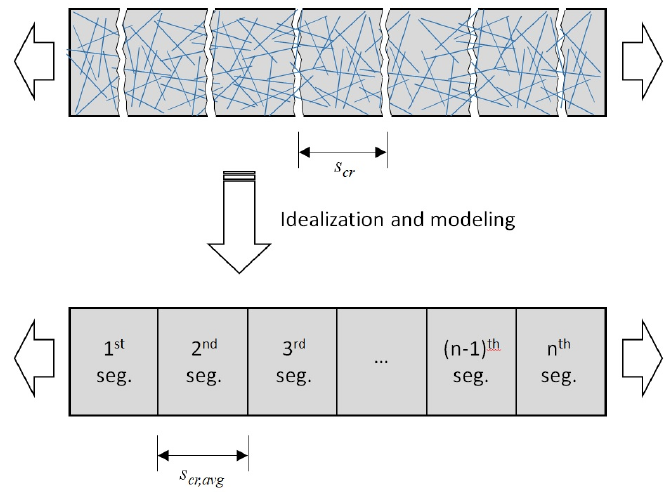
Figure 6. Analytical model with segments for an HPFRC member subjected to uniaxial tension.